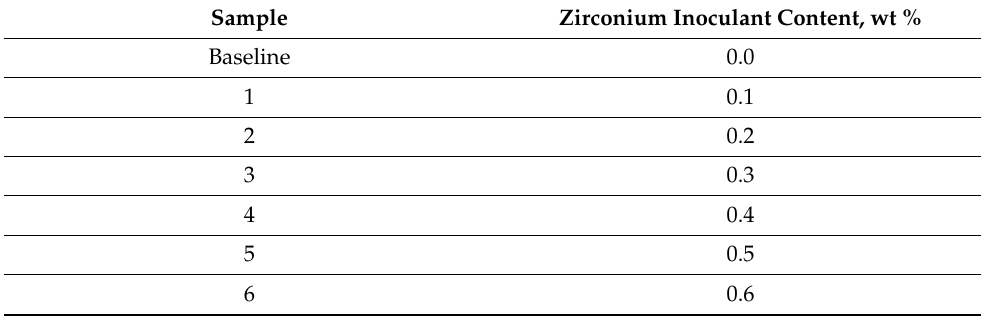
Table 2. Prepared magnesium alloy melt samples with different zirconium inoculant